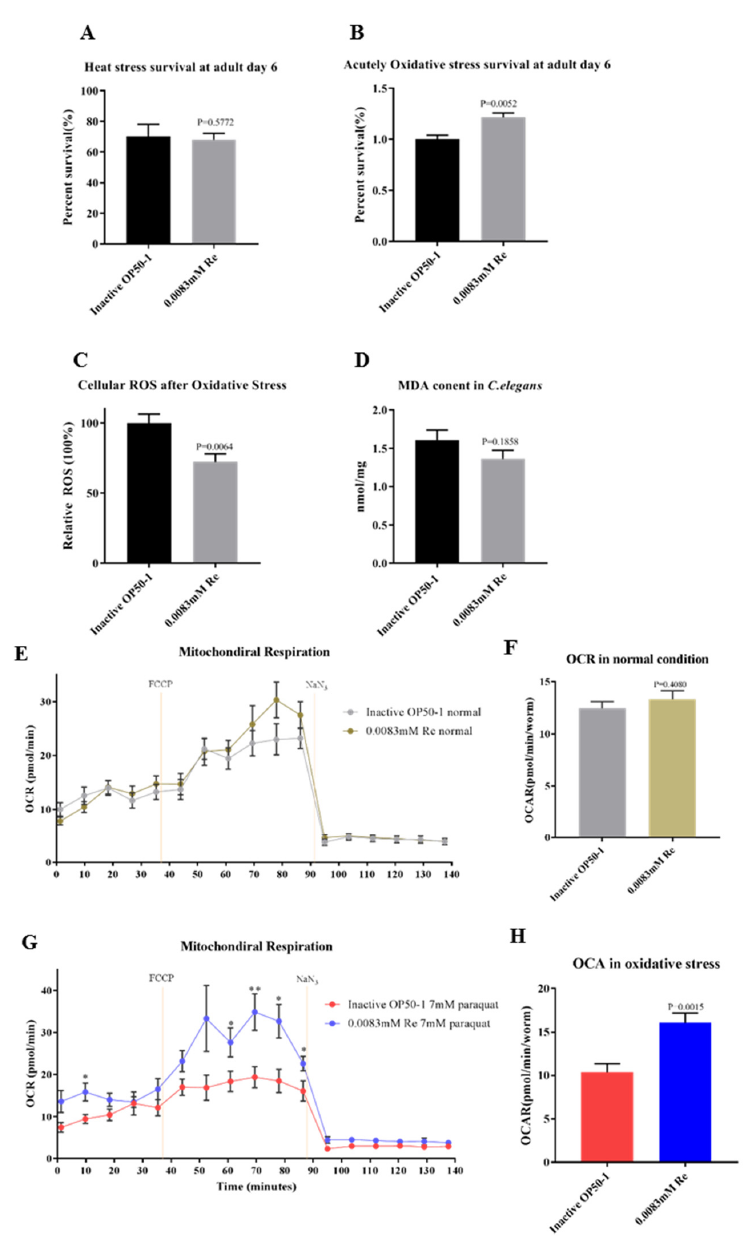
Figure 3. Reb A enhances resistance to oxidative stress in C. elegans . ( A ) Heat stress survival in the 6 ‐ day ‐ old adult worms from Reb A and control groups; ( B ) Acute oxidative stress (treatment with 200 mM paraquat for 2 h) survival in 6 ‐ day ‐ old adult worms from Reb A and control groups; ( C ) Relative cellular ROS level after treatment with 7 mM paraquat in the 6 ‐ day ‐ old adult worms from Reb A and control groups; ( D ) MDA content in the 6 ‐ day ‐ old adult worms from Reb A and control groups following oxidative stress exposure; ( E ) Under normal condition, basal respiration, maximal respiration, and spare capacity of 0.0083 mM Reb A ‐ treated 6 ‐ day ‐ old adults were not significantly different from those of the control group ( n = 16 wells); ( F ) OCR was not statistically different between the 6 ‐ day ‐ old adult worms treated with 0.0083 mM Reb A and the control group; ( G ) The 6 ‐ day ‐ old adult worms from the 0.0083 mM Reb A group showed increased basal respiration and maximal respiration after 2 h of 7 mM paraquat treatment as compared with the control group ( n = 12 wells), * p < 0.0021, ** p < 0.0332; ( H ) OCR under oxidative stress was significantly increased in 6 ‐ day ‐ old adult worms